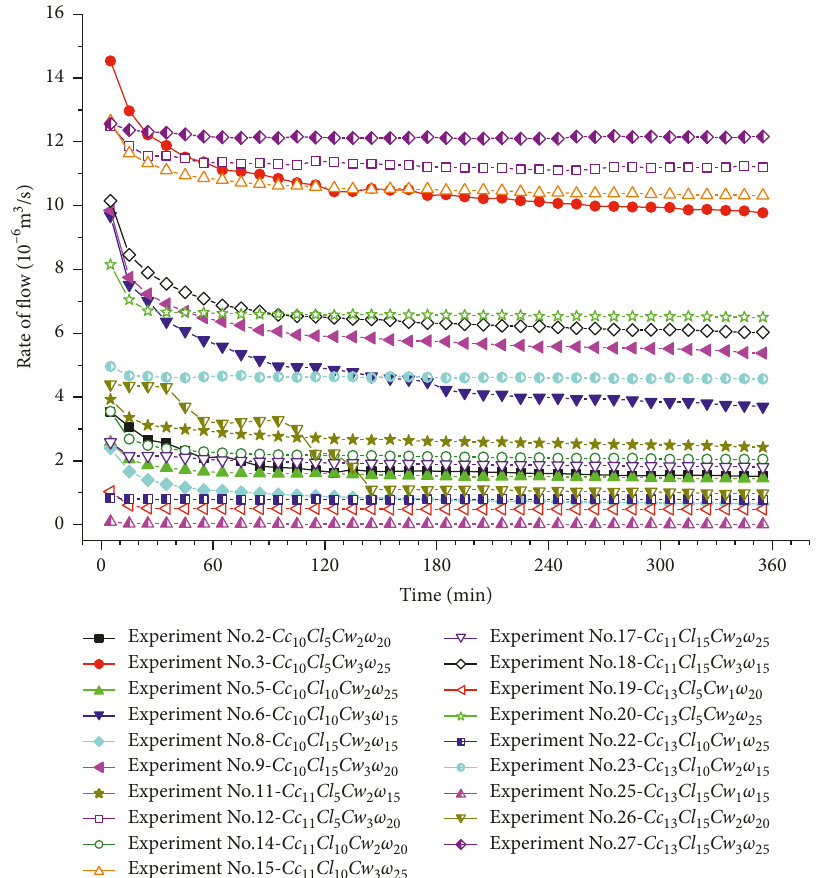
Figure 11: Change curve of the crack rate of flow between 0m 3 /s and ∞ m 3 /s.